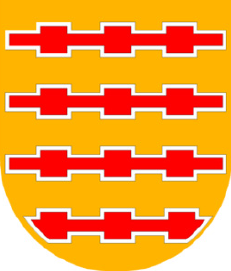
Figure 4. CoA of the King of Macedonia from Randle Holme, cf CEMRA, c. 1448 (emblazon by Ivan Nacevski).